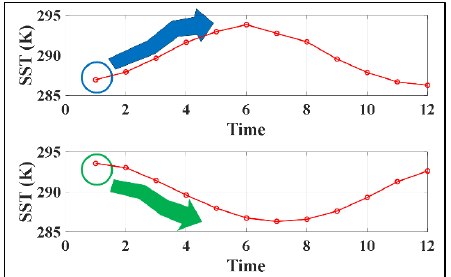
Figure 3. Variation trend of SST in a sliding window.